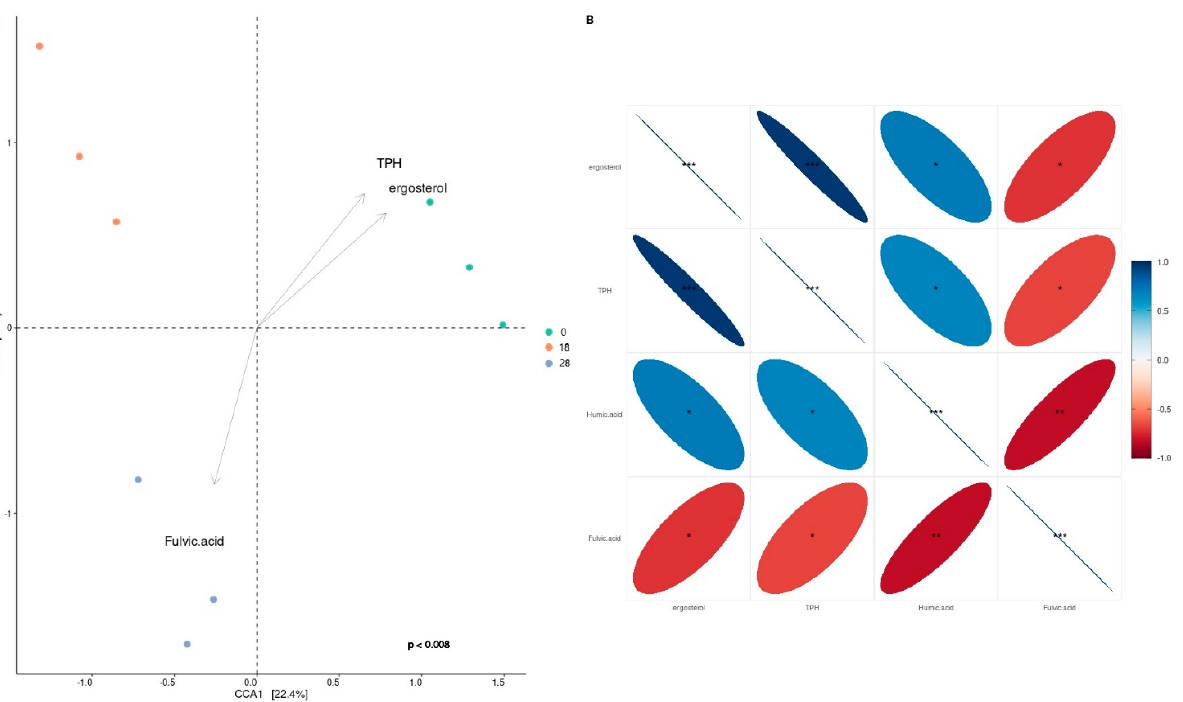
Figure 6. Canonical correspondence analysis (CCA) of Lambertella sp. MUT 5852 incubation. Canonical correspondence analysis (CCA) biplot ( A ) that shows correlation between ASV composition of each sample replicate and the environmental parameters: fulvic and humic acids, TPH, and ergosterol. Colours indicate time category for each datapoint. Black arrows are the eigenvectors representing constraining variables. Reported p -value is calculated by PermANOVA test performed on a full model with 999 permutations. ( B ): correlogram that reports correlation between environmental parameters, and biomarker and toxicological parameters. Heat colours and ellipse shapes represent the degree of correlation, based on Pearson coefficient. Notation for p -value: ns for p > 0.05; * for p ≤ 0.05; ** for p ≤ 0.01; *** for p ≤ 0.001, based on Fisher’s Z transformation of the aforementioned coefficients.